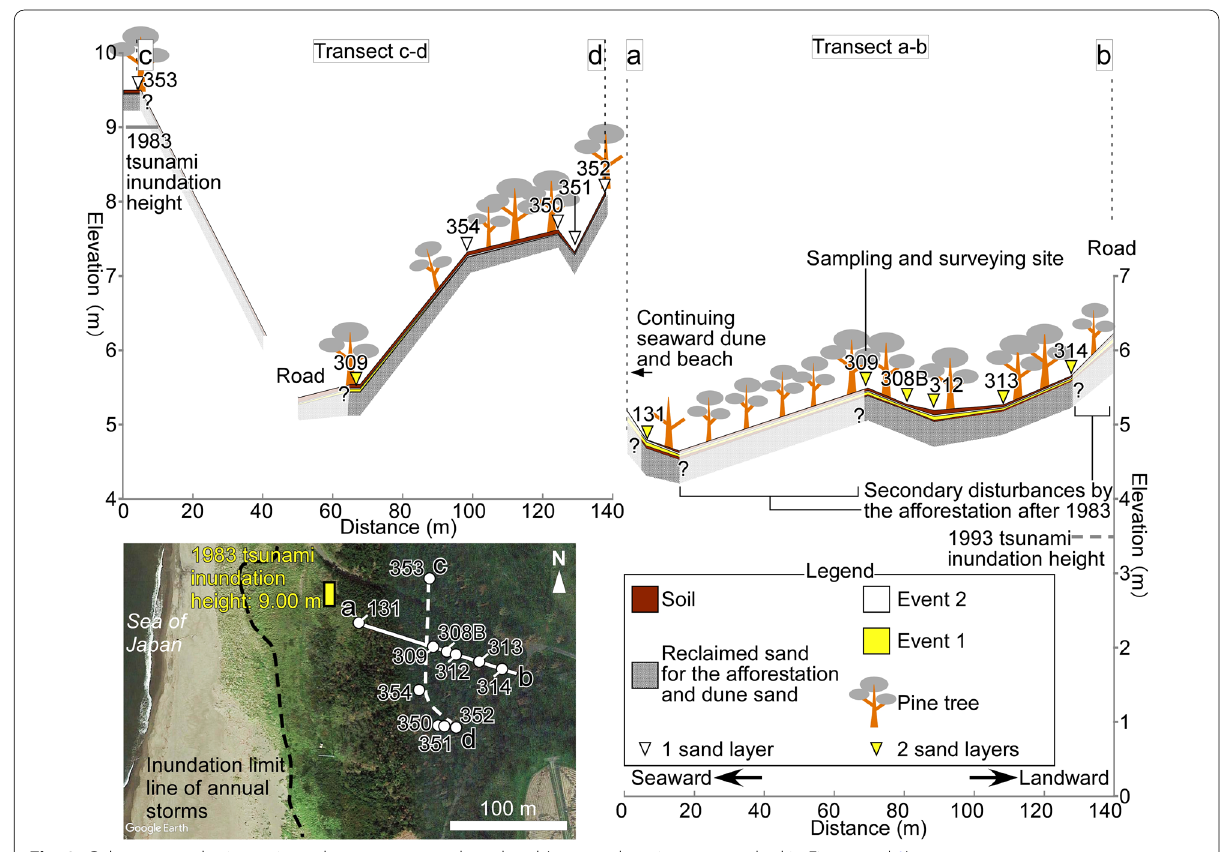
Fig. 3 Columnar geologic sections along transects a–b and c–d (transect locations are marked in Figs. 1 and